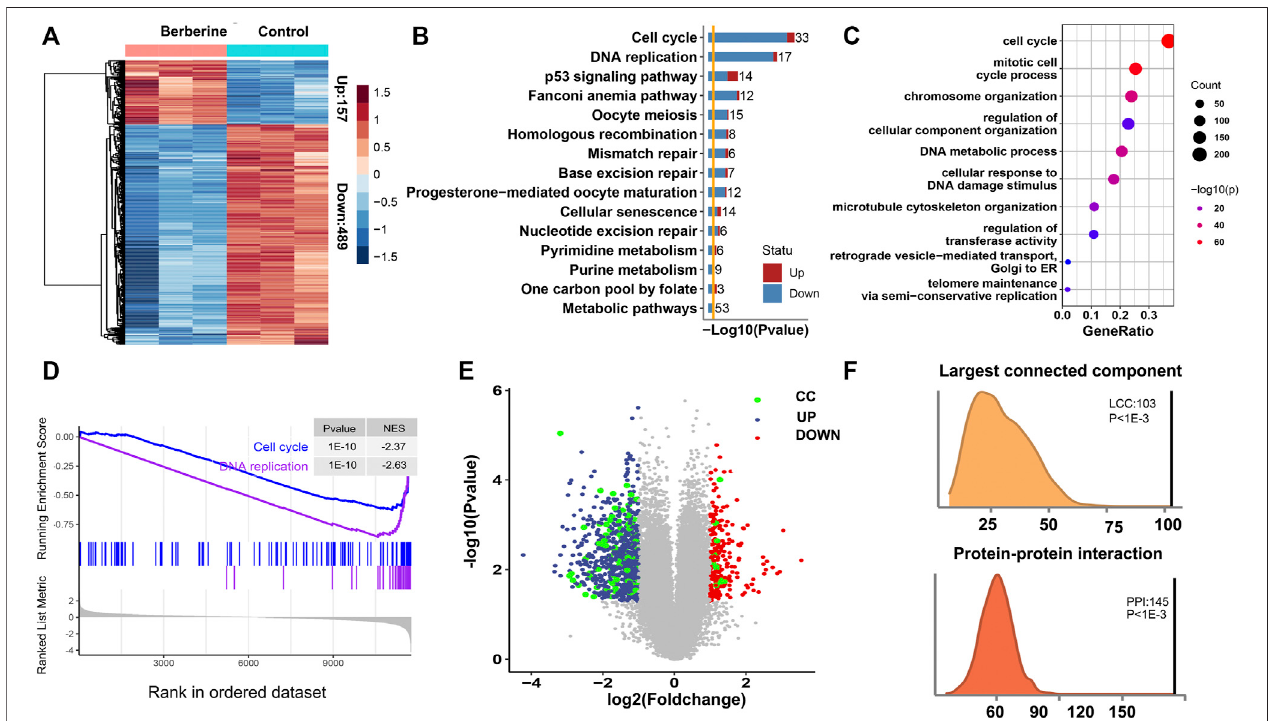
FIGURE1| Potentialantitumour mechanisms ofberberinein NSCLC. (A) Heatmap ofdifferential expression genehumanA549cellsafter berberinetreatment157 genes were up-regulated and 489 genes were down-regulated. (B) KEGG enrichment analysis showed that the DEGs were mainly enriched in Cell cycle and DNA replicationpathway afterberberinetreatment,andtended tobedown-regulated. (C) GeneOntologyenrichment analysisshowedthattheDEGsweremainlyenriched in Cell cycle gene set. (D) Enrichment Score of Cell Cycle and DNA replication pathway in the Berberine cohort. (E) Volcano plot of DEGs. Up-regulated genes were colored in red, down-regulated genes in blue and Cell cycle and DNA replication related genes in green. Cell cycle and DNA replication related genes were signi fi cantly down regulated. (F) Density plot of number of protein-protein interactions (PPIs) in the 1,000 randomized network and the observed PPIs, revealing signi fi cant enrichment for PPIs between CC-DEGs and other DEGs relative to random expectation ( p < 10 − 3 ); Density plot of size of the largest connected component (LCC) in the 1,000 randomized network and the observed LCC, revealing CC-DEGs densely interact with other DEGs ( p < 10 − 3